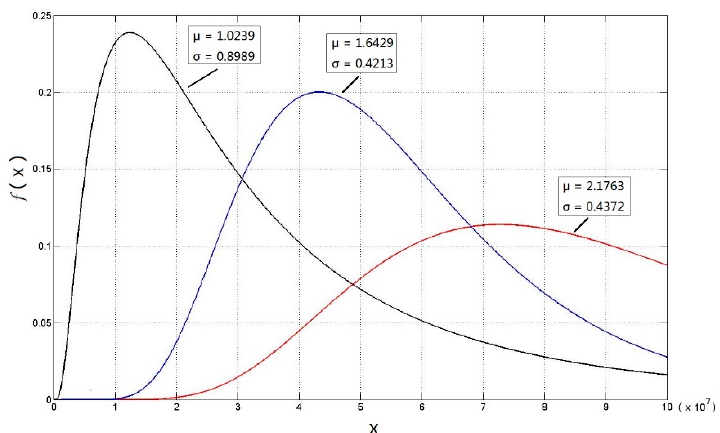
Figure 6. The fatigue life probability density function curves of FV520B-I.